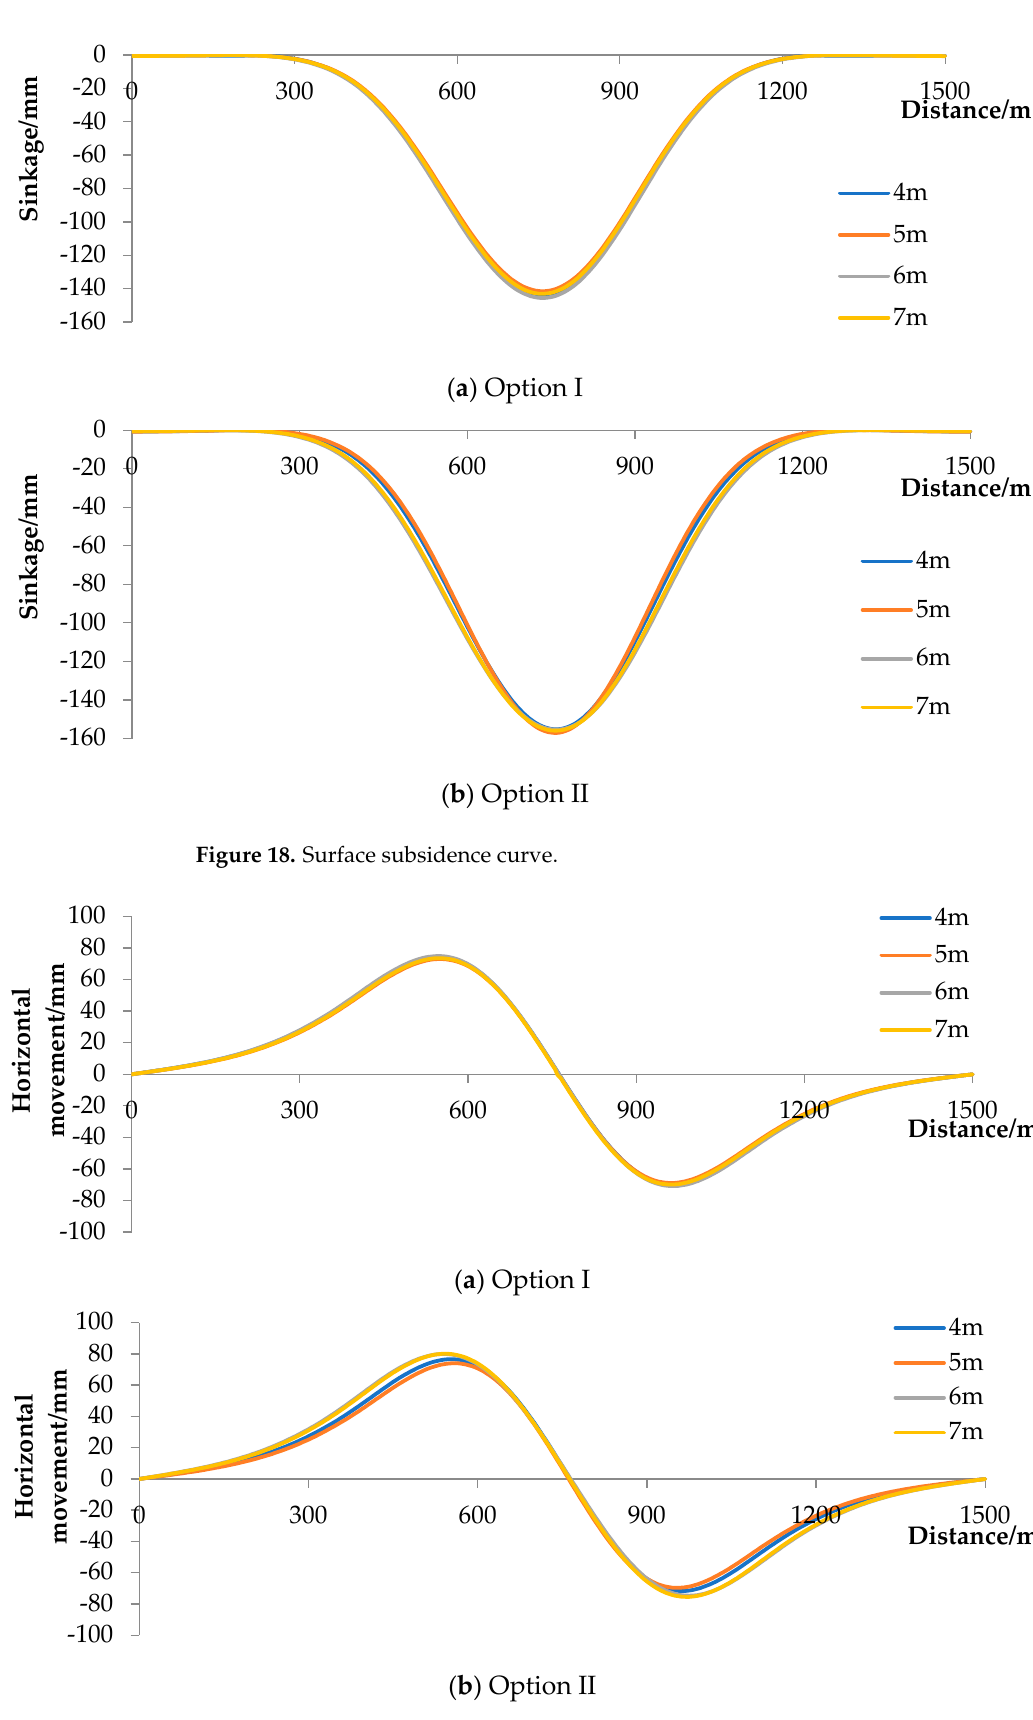
Figure 19. Surface horizontal movement curve. Table 6. Surface deformation under different mining width conditions.